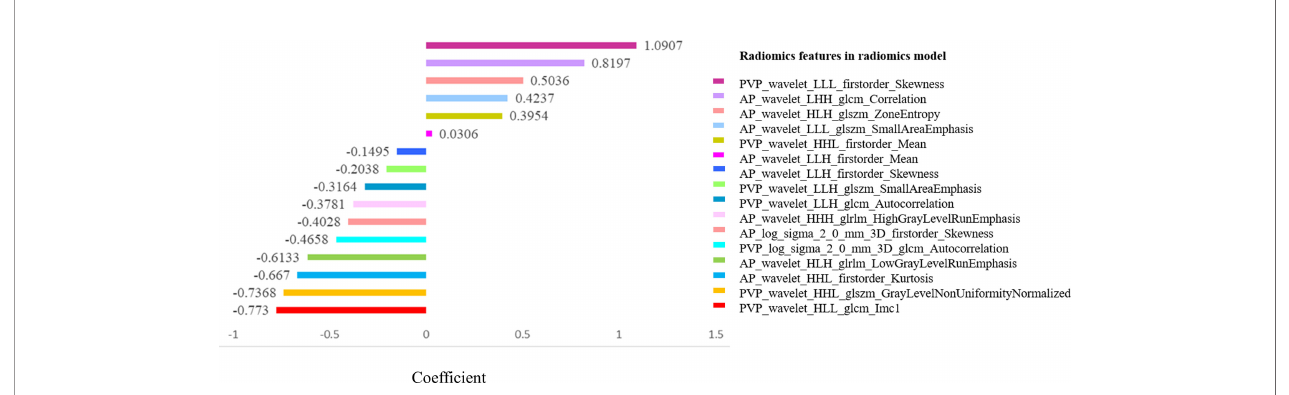
FIGURE 3 | Correlation coef fi cients of selected radiomic